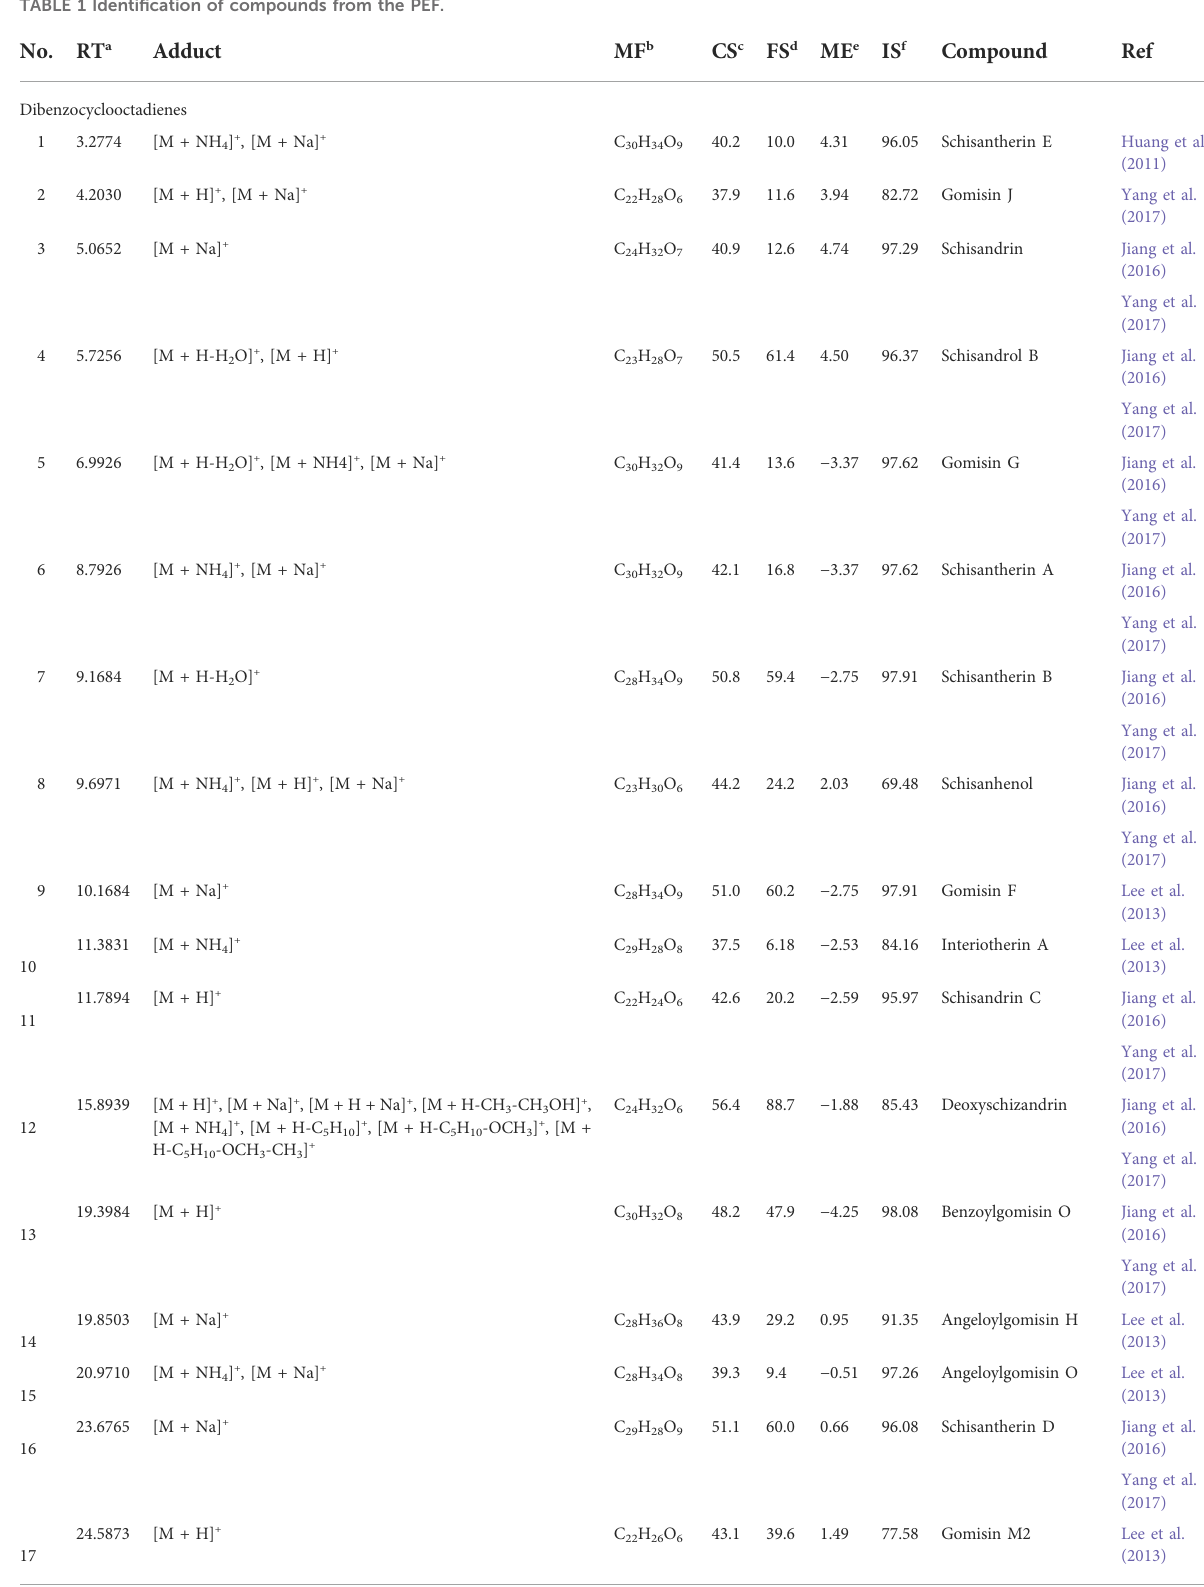
TABLE 1 Identi fi cation of compounds from the